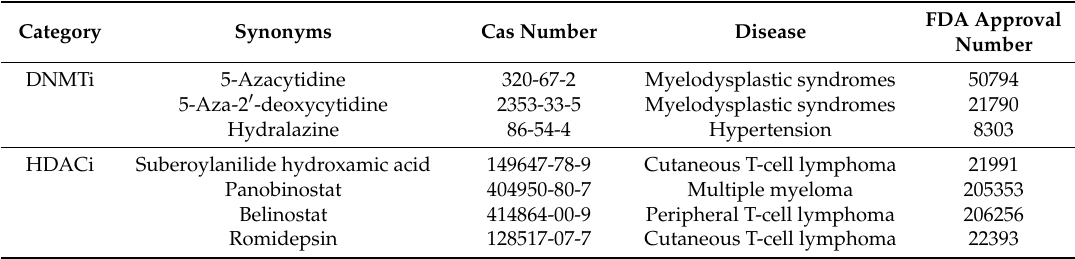
Table 1. FDA-approved epigenetic